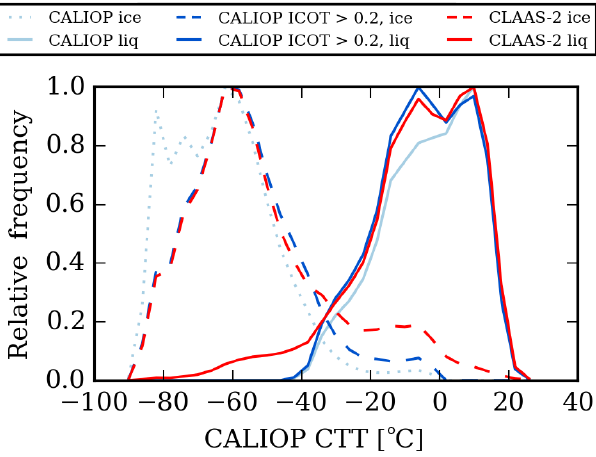
Figure 3. Phase histograms for liquid and ice clouds as a function of CALIOP cloud top temperature. For the red and blue lines, bin- ning is based on the CALIOP CTT taken from the layer at which ICOT exceeds 0.2. For the light blue line, the phase and tempera- ture of the uppermost CALIOP cloud layer were used. Bin size is 4 ◦